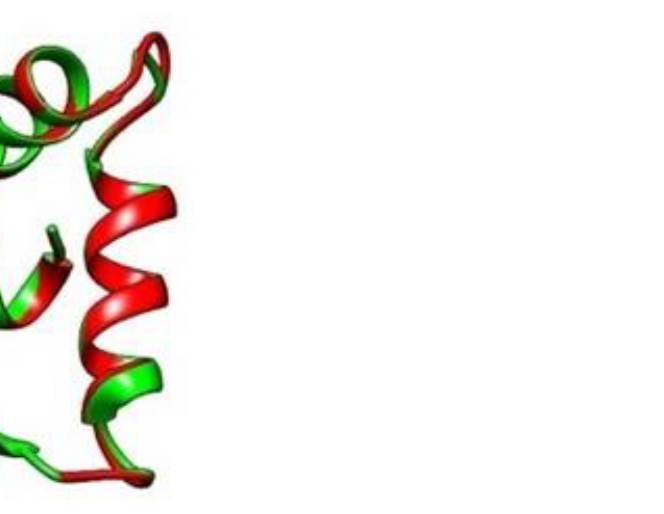
Figure 3. ERF structures were superimposed in UCSF Chimera and were found to be structurally dissimilar (RMSD across all pairs: 29.567 Å ).